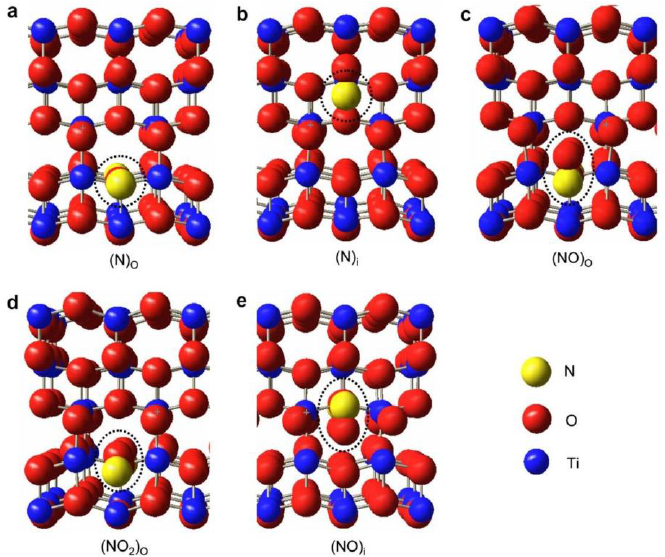
Figure 5. Schematic models for ( a ) substitutional N-doping, ( b ) interstitial N-doping, ( c ) substitu- tional NO-doping, ( d ) substitutional NO 2 -doping, and ( e ) interstitial NO-doping. Reprinted with permission from Ref. [124]. Copyright 2007, Elsevier.